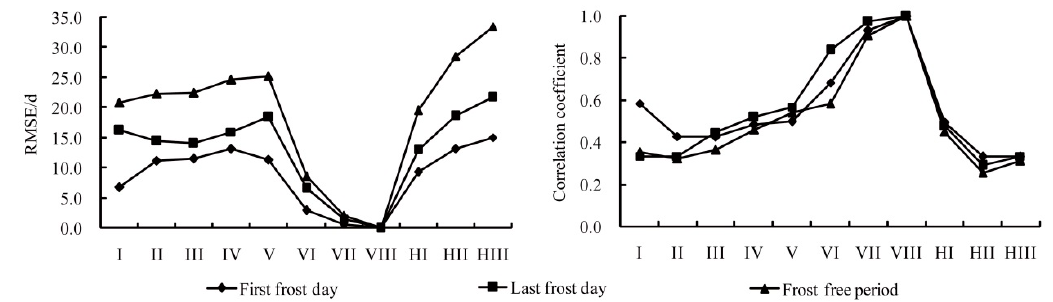
Table 4. The number and percentage (in bracket) of the sites where the observed and gridded frost Figure 12. Root mean-square error (left) and correlation coe ffi cient (right) of first frost day, last frost Figure 12. Root mean-square error (left) and correlation coefficient (right) of first frost day, last frost data are with the same climate trends (OGSP index) and opposite climate trends in mainland China. day and frost-free period. day and frost-free period.